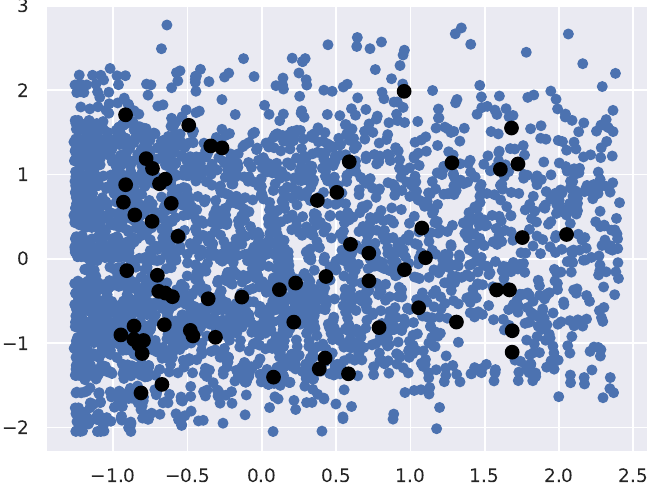
Figure 2. Prototype extraction using K-means. The set of prototypes (in black) constitutes a generalization of the observed states (in blue). The features of the states are mainly distances and velocities which represent a dynamic